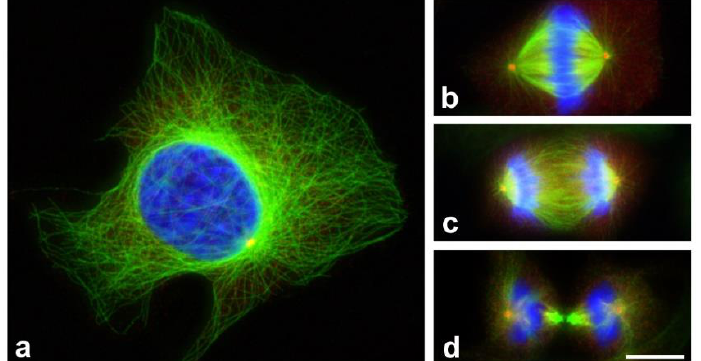
Figure 1. Microtubule nucleation during the cell cycle. Microtubules nucleated from centrosomes undergo substantial reorganization throughout the cell cycle. Human osteosarcoma U2OS cells in interphase ( a ), metaphase ( b ), anaphase ( c ), and late telophase ( d ) stained for microtubules with polyclonal anti- α -tubulin antibody (Genetex, GTX 15246; green) and for centrosomes with monoclonal anti- γ -tubulin antibody TU-30 [19] (red). DNA in blue. Formaldehyde-fixed samples were extracted with Triton X-100 and postfixed in methanol. Scale bar, 10 μm.